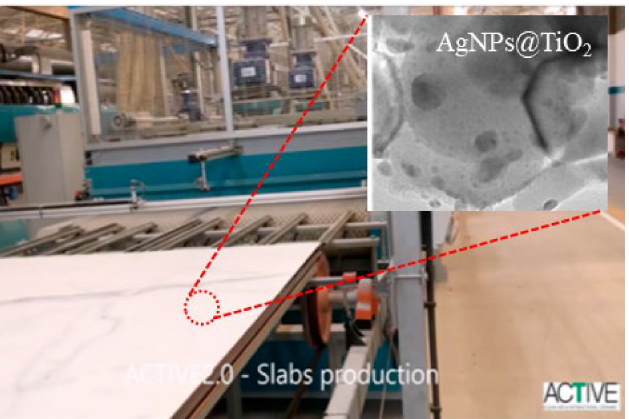
Figure 4. Photocatalytic self-cleaning industrial ceramics based on Ag nanoparticle-decorated TiO2 (inset) (by IrisCeramica Group—Italy) for the purification of contaminated air and bacteria inactiva- tion, reproduced with permission from reference